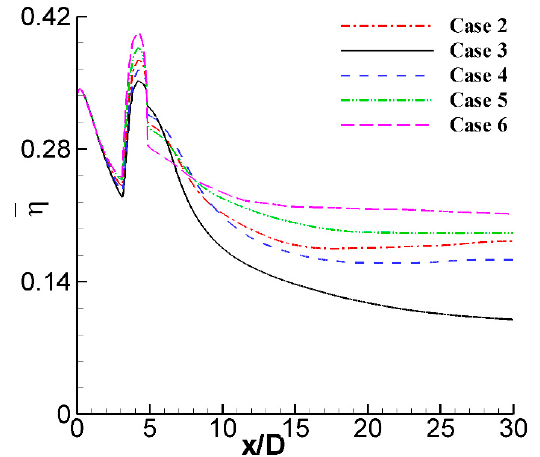
Figure 14. Spanwise-averaged film cooling effectiveness 𝜂̅ of Case 2–6.